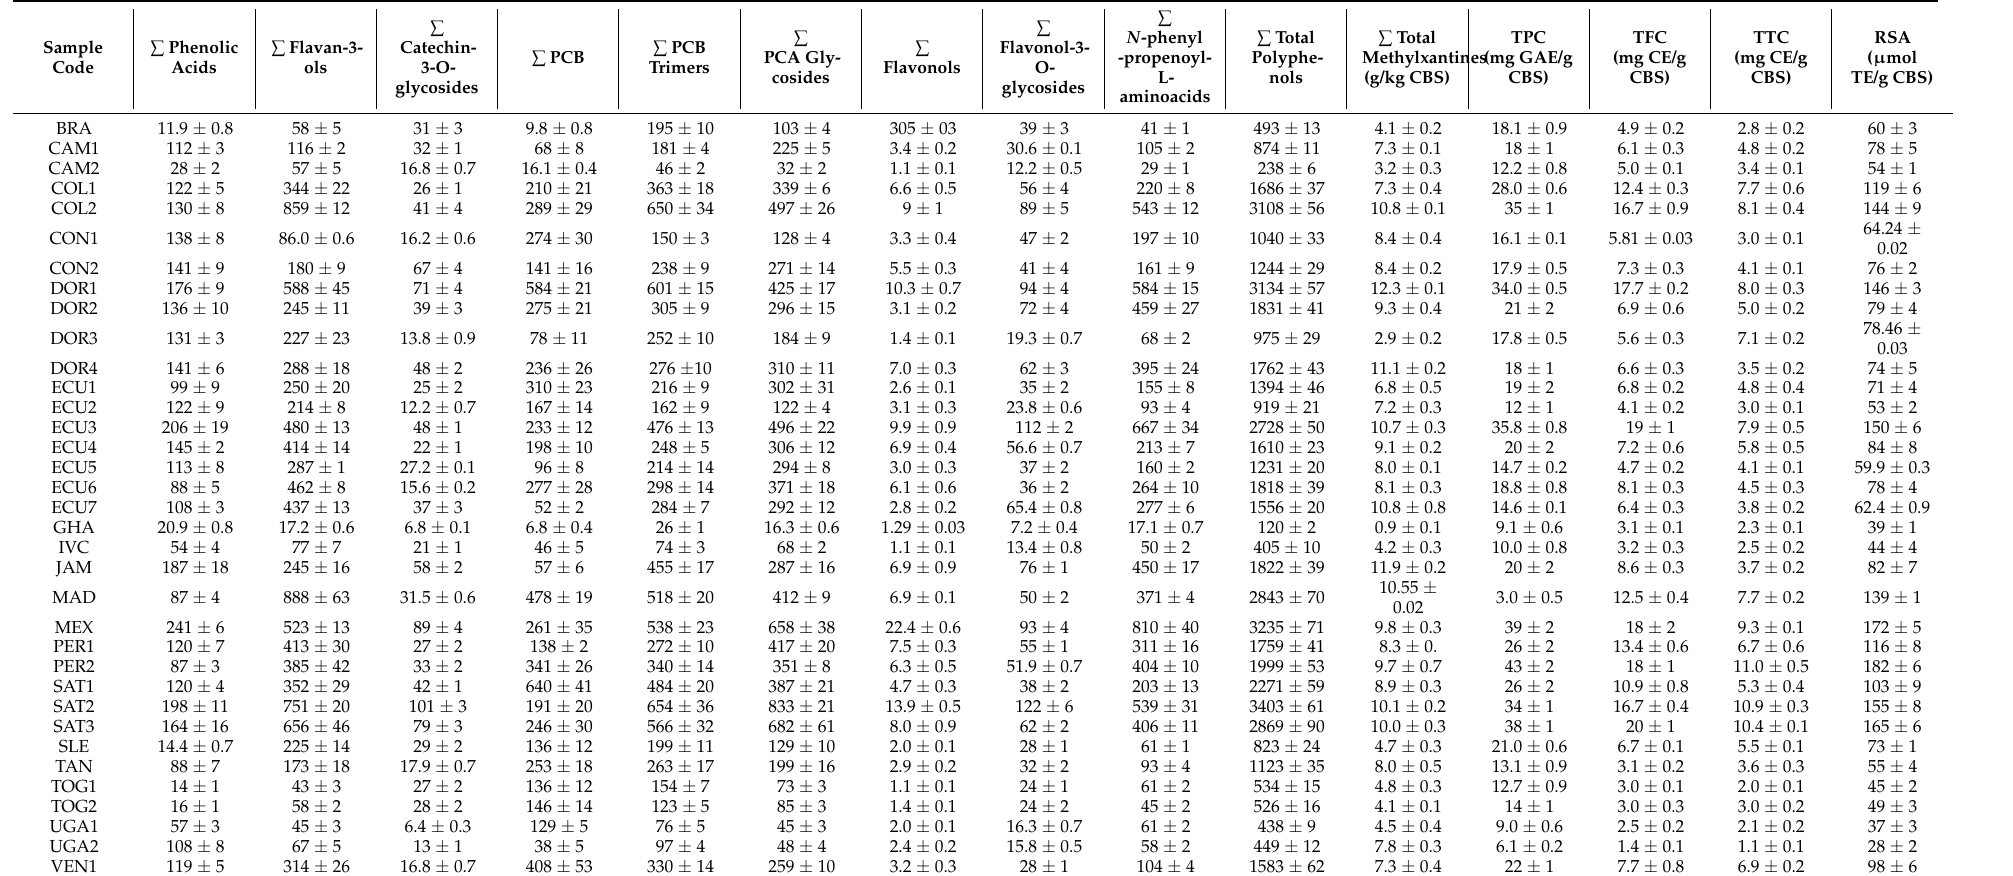
Table 3. Sums ( ∑ ) for total contents of different polyphenolic categories, methylxanthines, and spectrophotometric assays values determined in CBS powders from different geographical origins and varieties. Concentrations are expressed as mg/kg CBS, unless indicated differently. An extended version of this table with the individual compound concentrations can be consulted in Table S1 of the Supplementary Materials. Data are presented as mean ( n = 4) ± standard